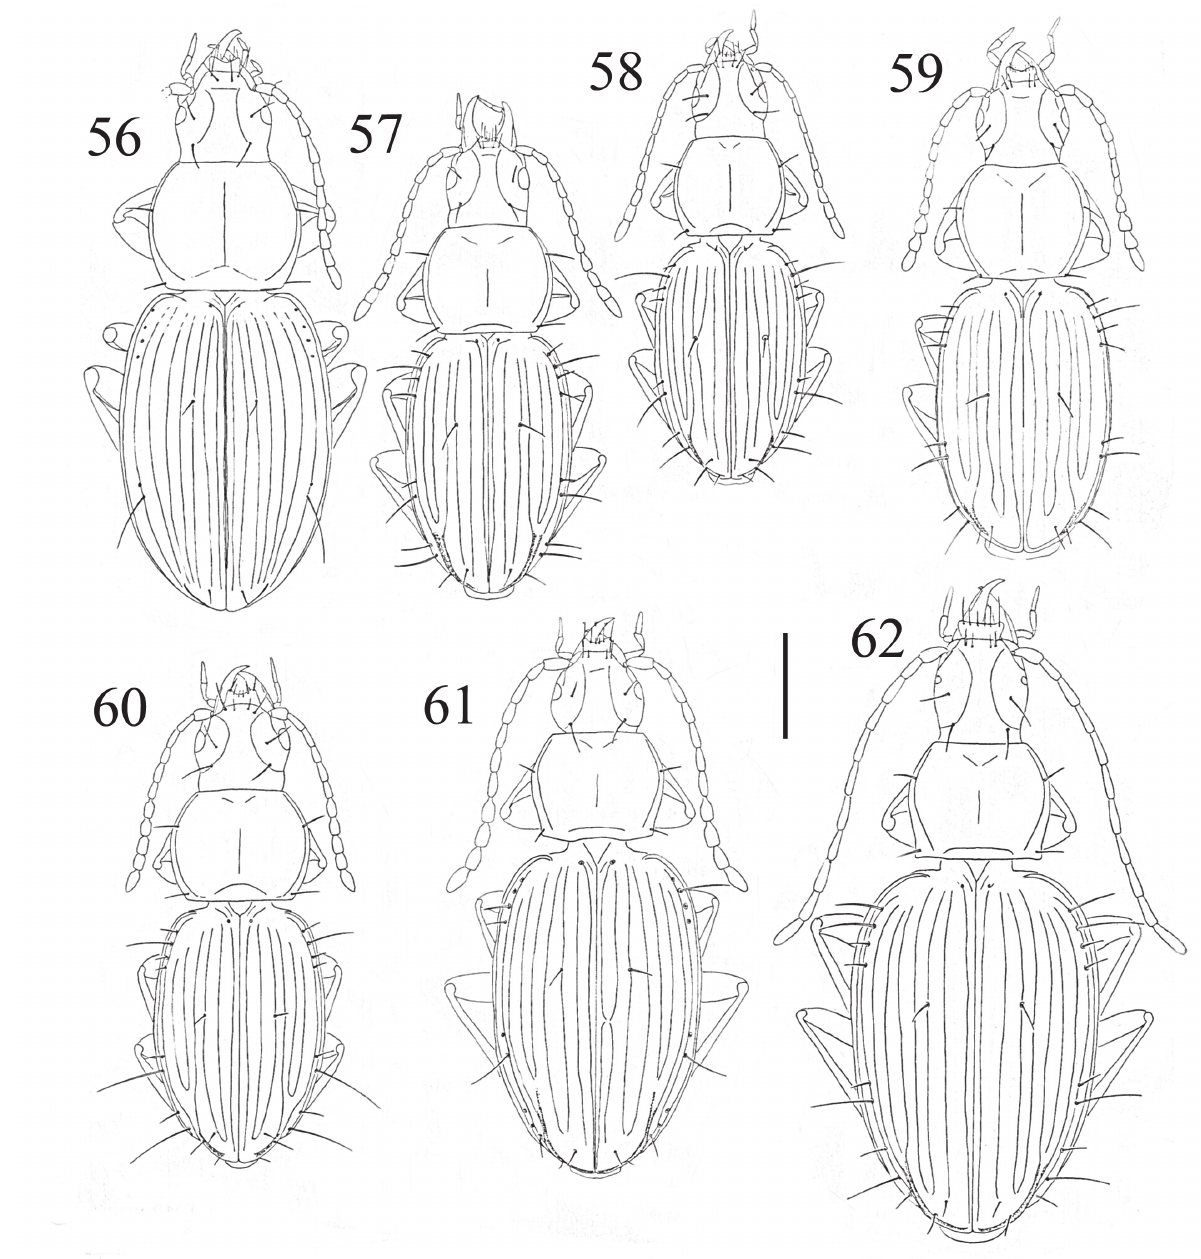
Figs 56-62. Habitus of Tasmanotrechus spp.: 56) T. leai (Sloane), HT ♀ from Cradle Mt.; 57) T. gordoni sp. nov., HT ♂ from Her- itage Landing Walk; 58) T. alticola sp. nov., HT ♂ from Cradle Plateau; 59) T. montisfieldi sp. nov., HT ♀ from Mt. Field; 60) T. osbornianus sp. nov., HT ♂ from Lake Osborne; 61) T. moorei sp. nov., HT ♂ from Kubla Khan Cave; 62) T. rolani sp. nov., HT ♂ from Little Trimmer Cave. Scale: 1